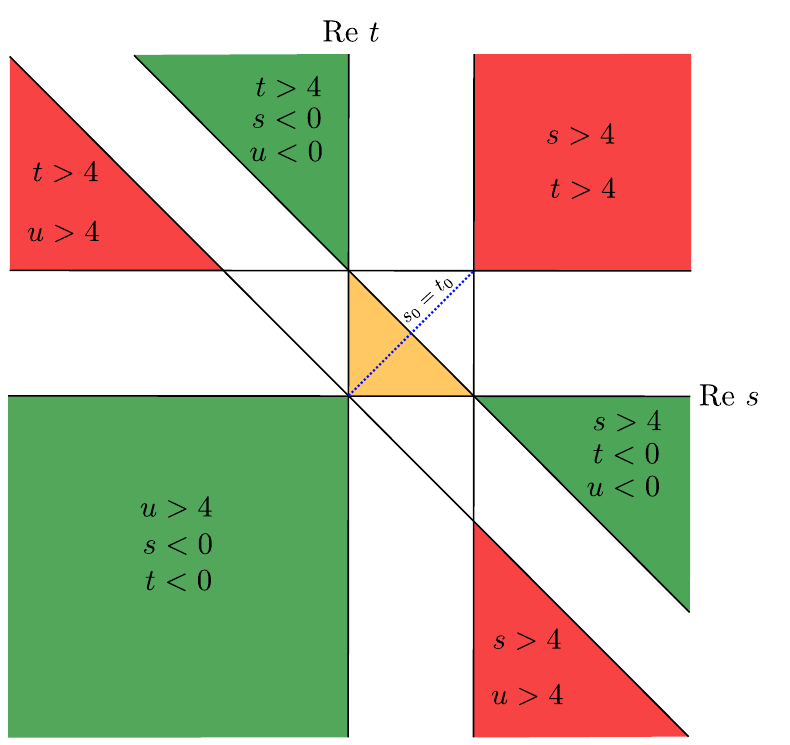
Figure 2. Mandelstam diagram in the real ( s , t , u ) plane. The red regions are the Mandelstam regions where the amplitude spectral densities ρ st and ρ su in (4.45) have support. The green regions are the physical regions in the s , t and u channels where the dual amplitudes (4.58) and (4.64) have double jumps. The triangles in the middle are the Mandelstam triangles where we usually evaluate the amplitude for maximization and the diagonal blue line s 0 = t 0 is where we maximize the amplitude to produce figure